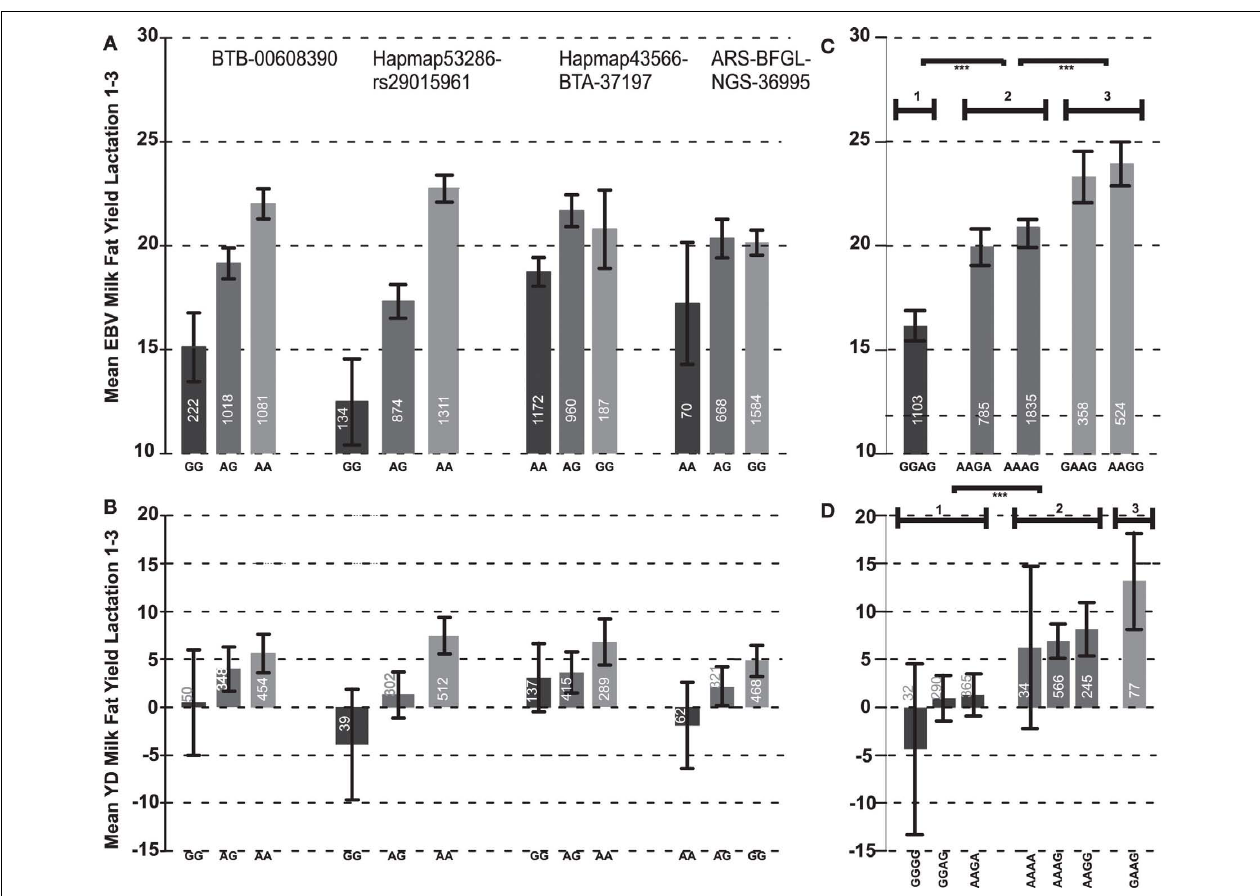
first three lactations. Effect plots of haplotypes in bulls (C) and cows (D) ; parentheses indicate significant differences between the groups (*** p < 10 − 3